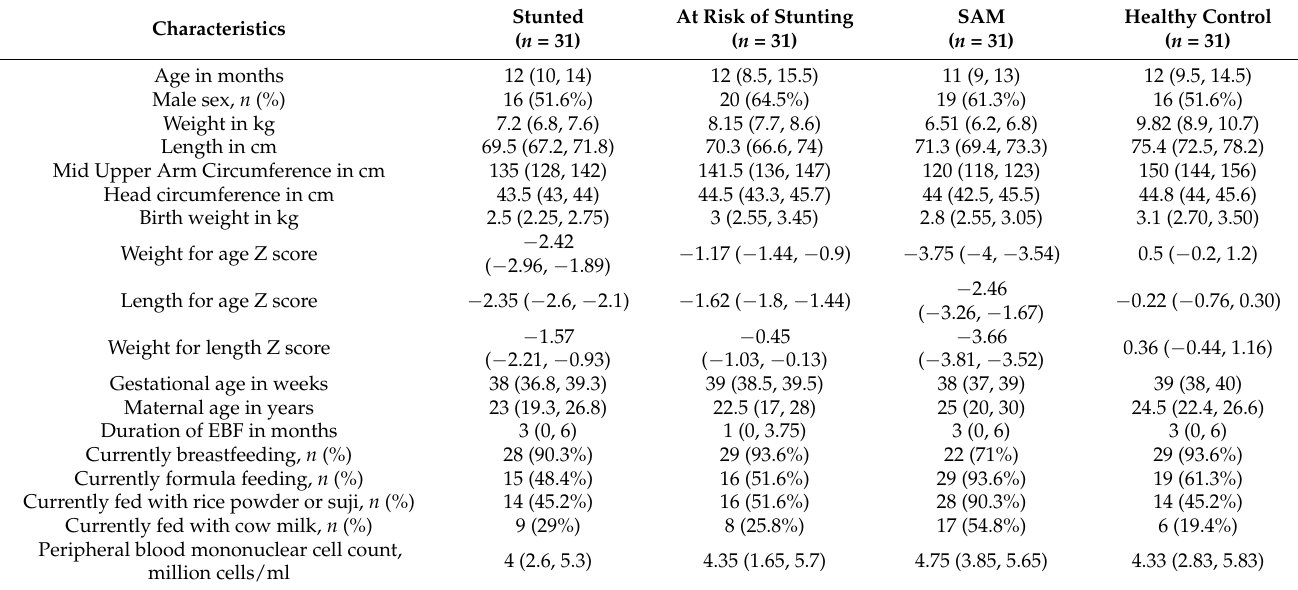
Table 1. Socio-demographic, anthropometric and nutritional data collected from the study partici- pants, distributed across the four study